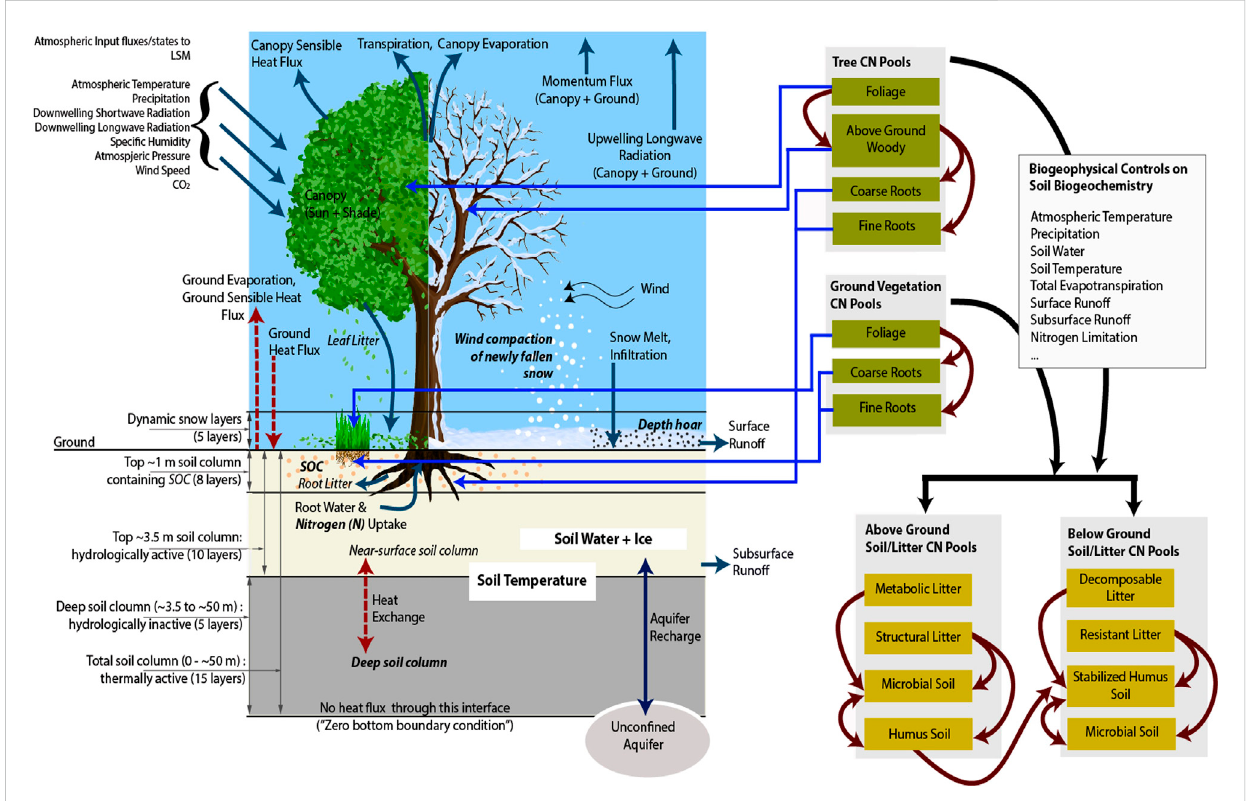
FIGURE 1 Conceptual diagram of coupled biogeophysics and biogeochemistry ISAM land